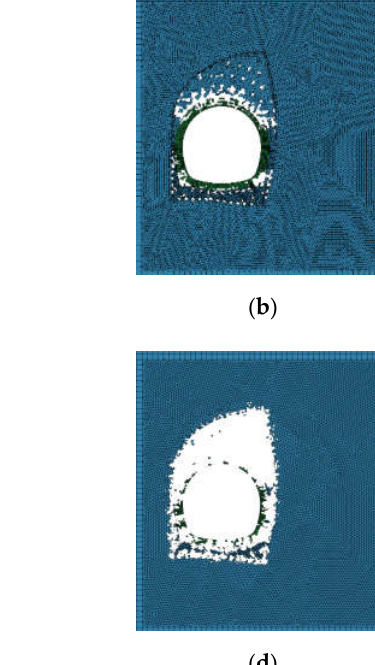
Figure 5. Sate of tunnel lining and rock in blasting process: ( a ) T = 0.4 × 10 −4 s; ( b ) T = 0.16 × 10 −3 s; ( c ) T = 0.4 × 10 −3 s; ( d ) T = 0.8 × 10 −3 s.